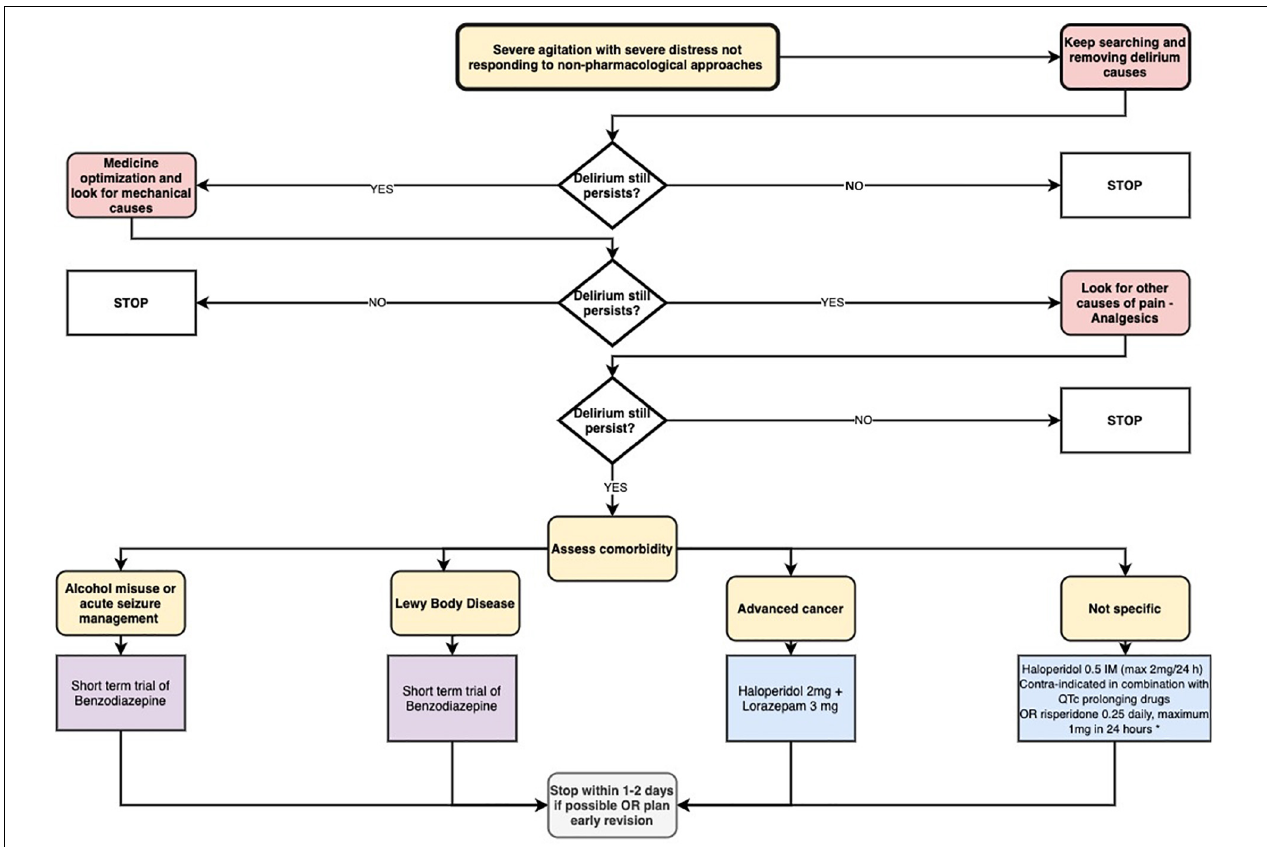
FIGURE 3 | Proposed pharmacological approach for the agitated delirium (Delirium: diagnosis, prevention, and management. NICE clinical guideline n. 103, 2010). * The single study supporting this indication was restricted to patients with advanced cancer in end-of-life care. Please note that this treatment option should be considered for refractory symptoms only (after antipsychotics have